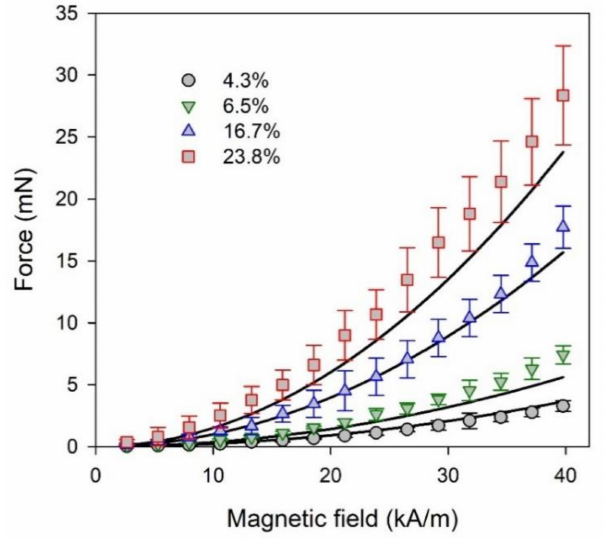
Figure 6. Mechanical forces emerged in ferrogel samples in a non-uniform magnetic field as a function of the field intensity at the surface of the electromagnet. Symbols correspond to the experimental values measured for the ferrogel sampes with different weight fraction of magnetite particles given in the legend. Lines are plots calculated using Equation